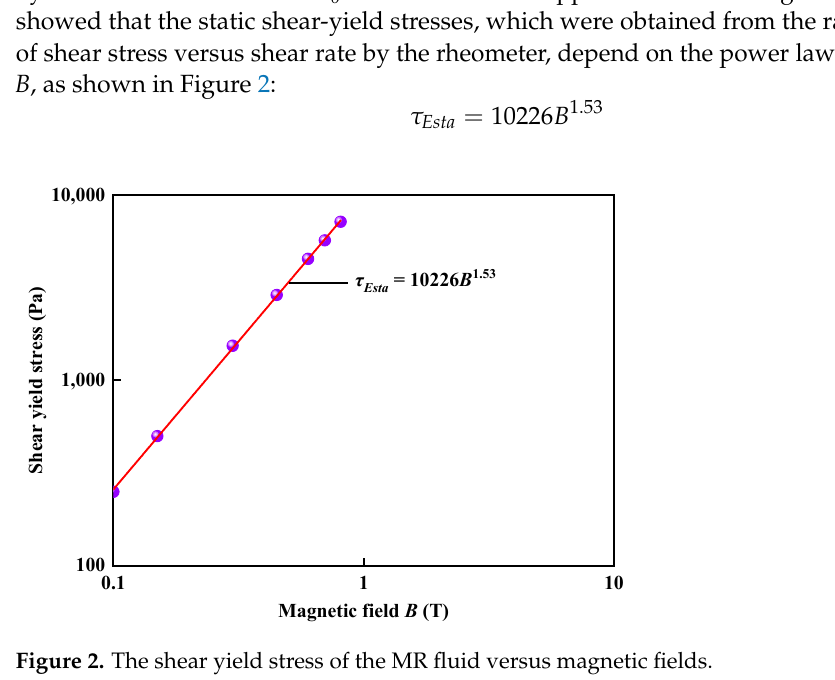
Figure 2. The shear yield stress of the MR fluid versus magnetic fields.